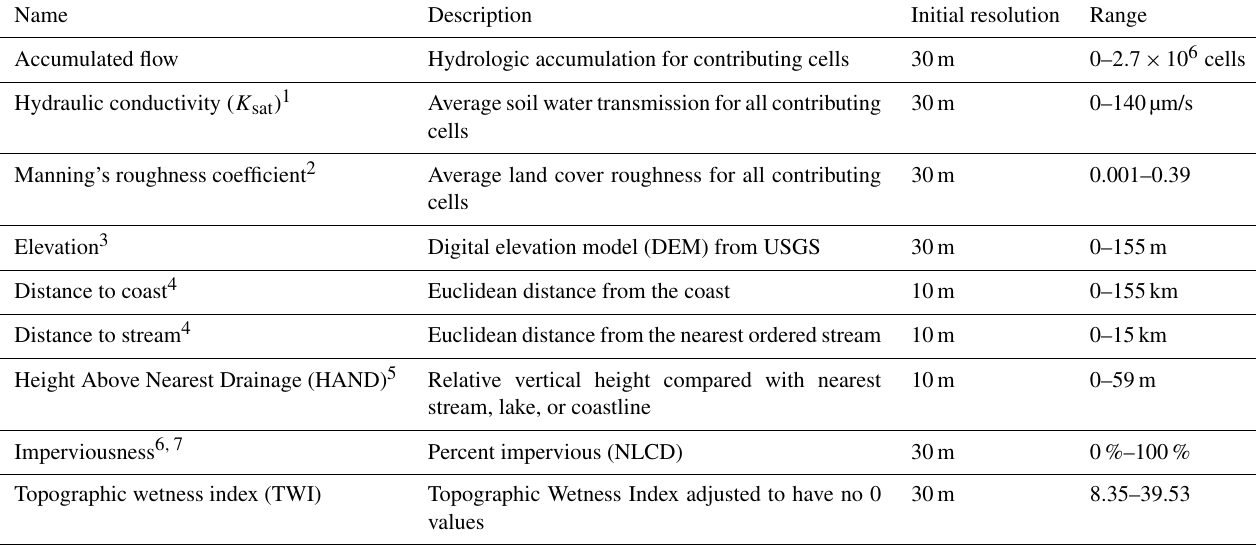
Table 1. Concept